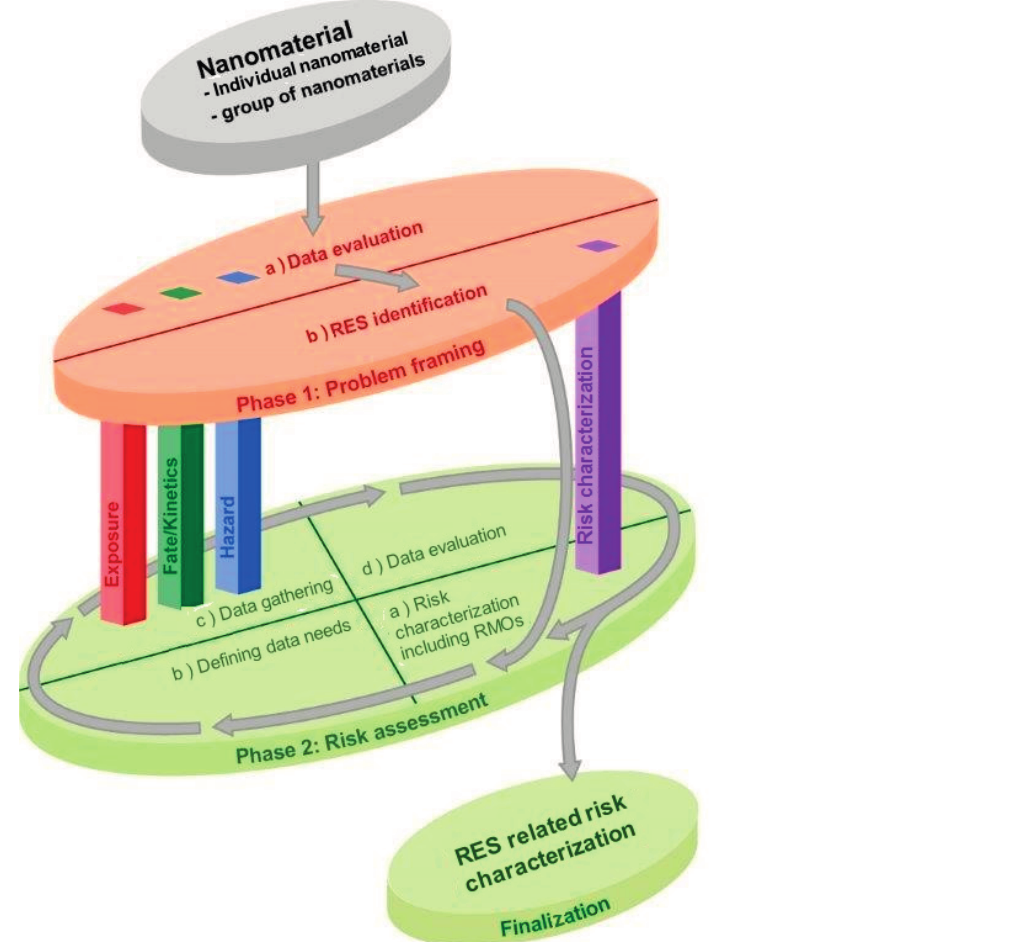
Figure 3. Schematic overview of the MARINA Risk Assessment Strategy, consisting of an overarching Phase 1: Problem Framing (orange), and the iterative Phase 2: Risk Assessment (green) with a cyclic evaluation process. The information gathering is organised in three pillars (Exposure, Fate/Toxicokinetics and Hazard). The integration of the gathered information to derive a conclusion on risk is represented by a separate pillar i.e ., Risk characterization. Each pillar comprises tools both for Phases 1 and 2 (from Bos et al . [8]). RES: Relevant Exposure Scenario. RMO: Risk Management Options. Several different possibilities for application of grouping and read-across in the two Phases of the MARINA RAS are illustrated in Figure 4; the numbers of the following sections correspond to the numbers in Figure